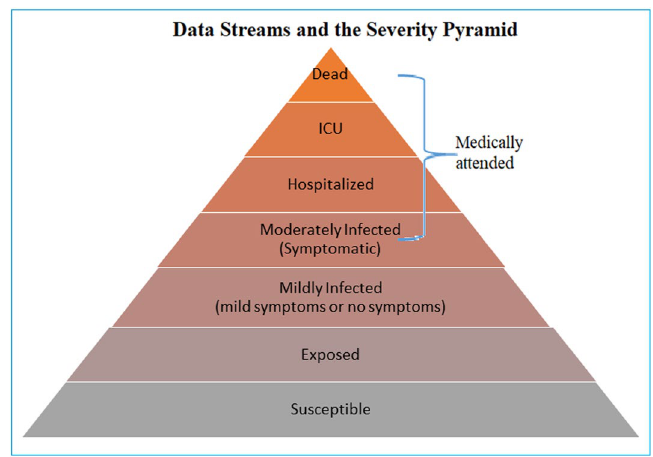
Figure 1. The different stages of the compartment model.